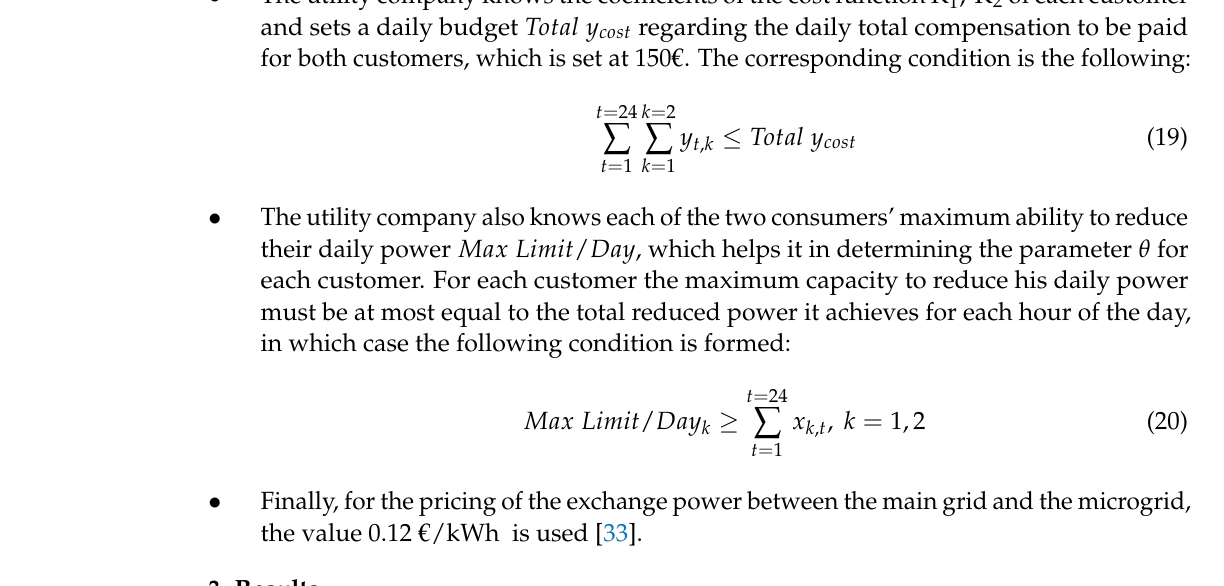
Figure 7. Initial total demand.